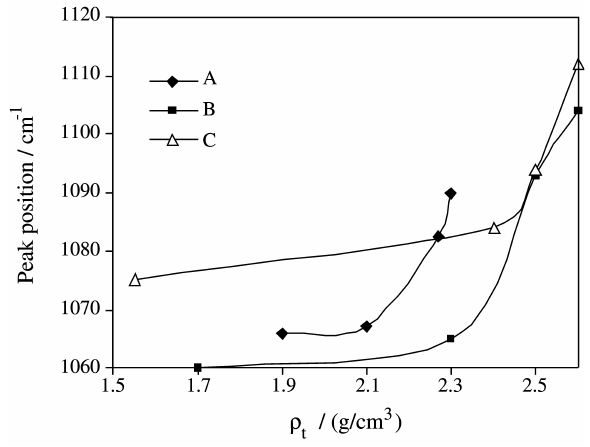
Figure 5. Asymmetric stretching mode of SiO 2 (ASTO) peak position as a function of true